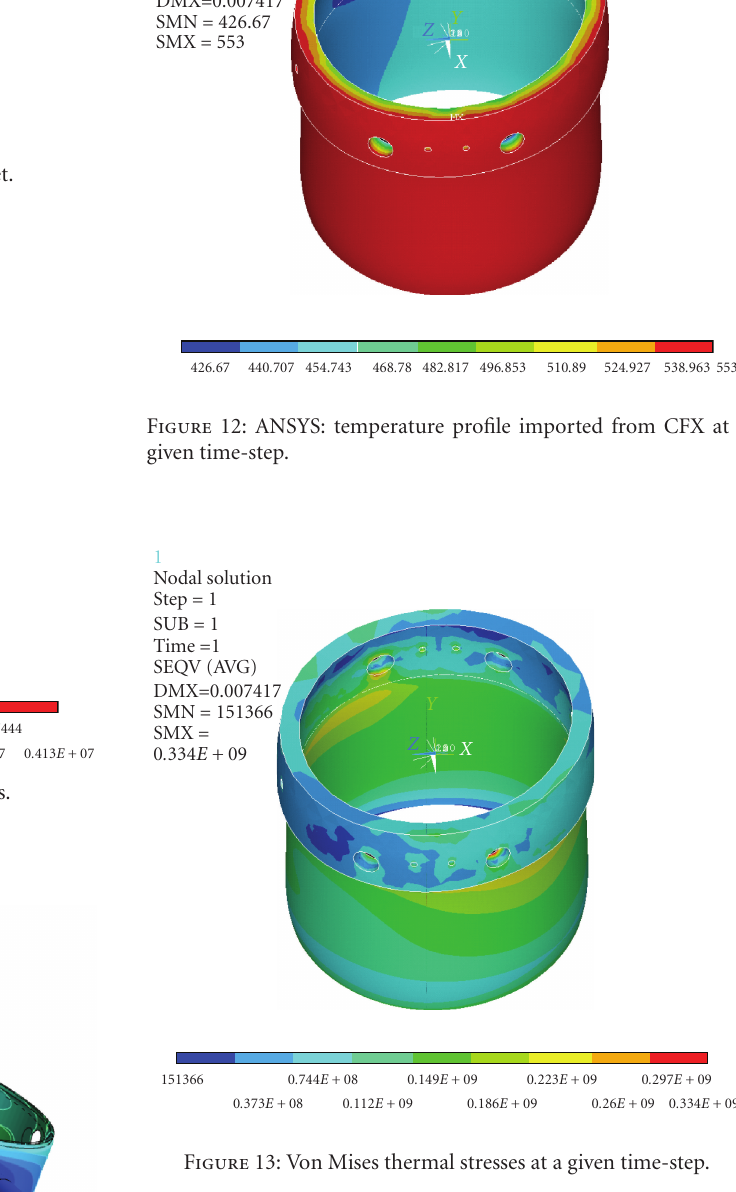
Figure 13: Von Mises thermal stresses at a given